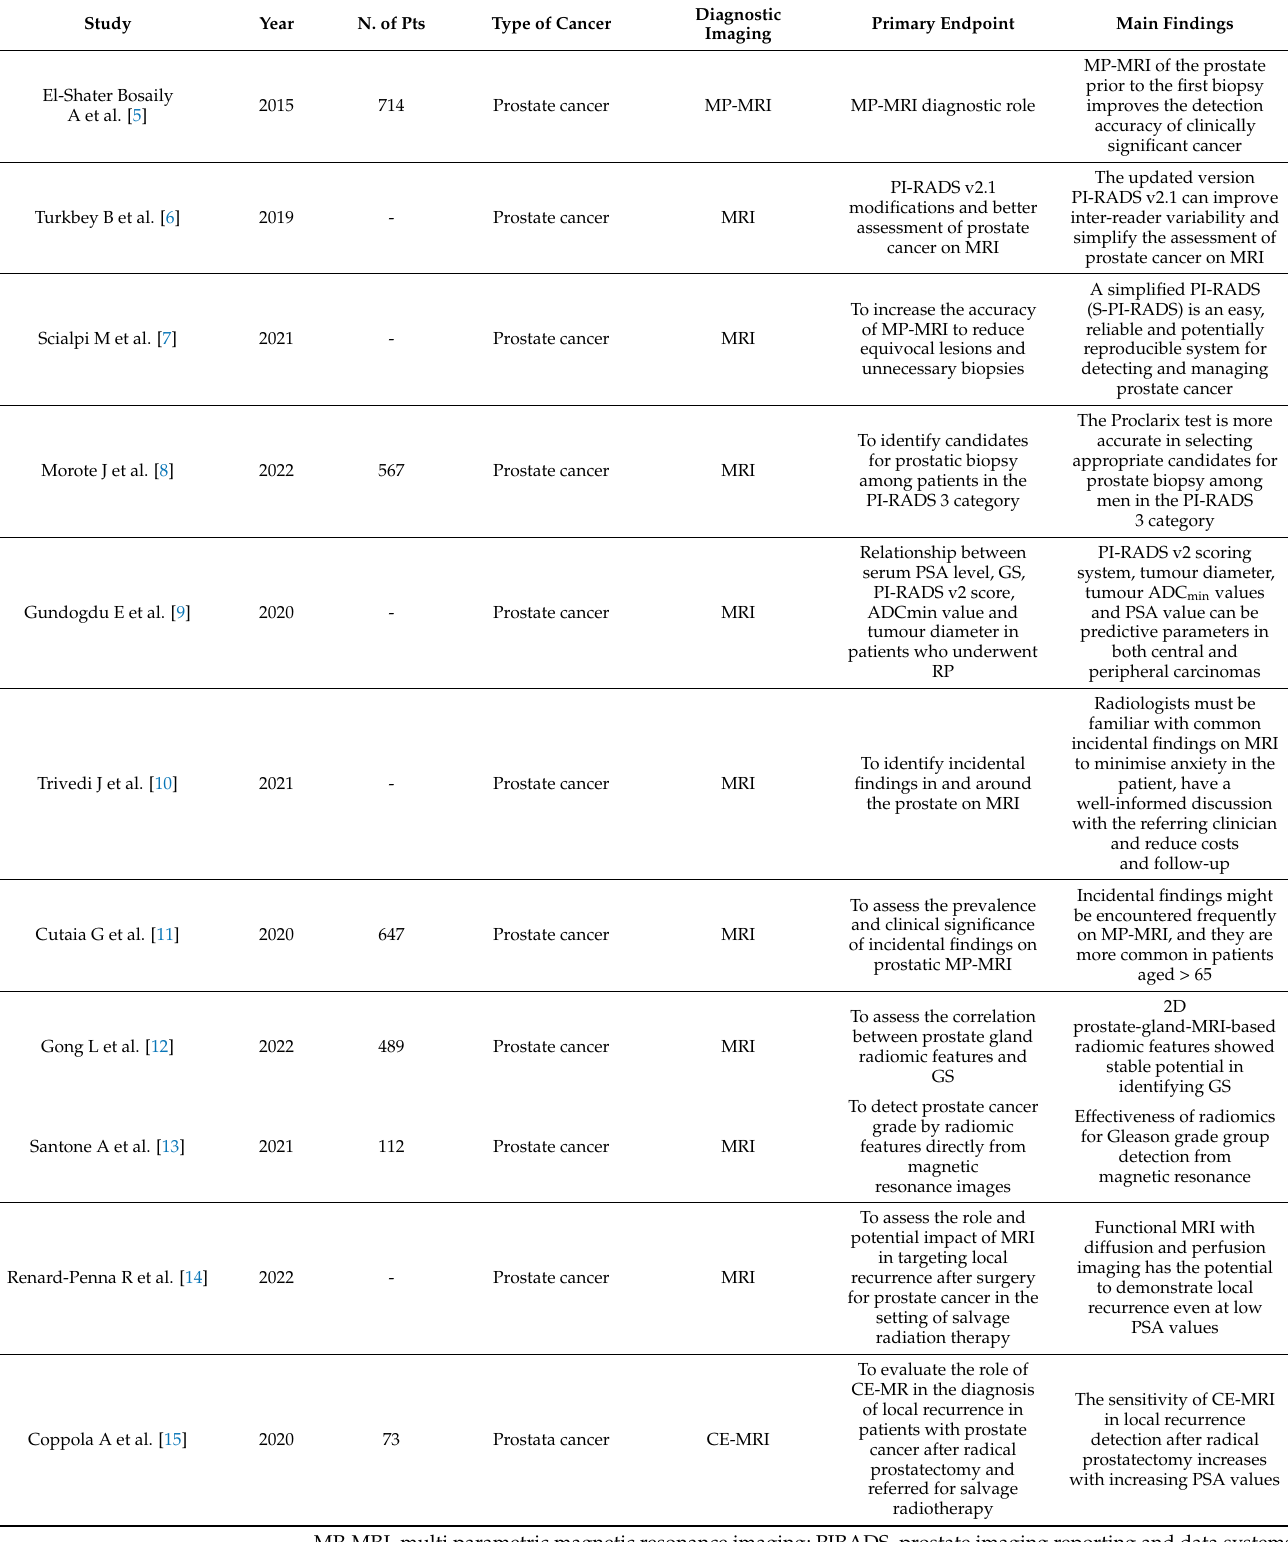
Table 2. Diagnostic imaging and predictive value before cancer treatment in prostate